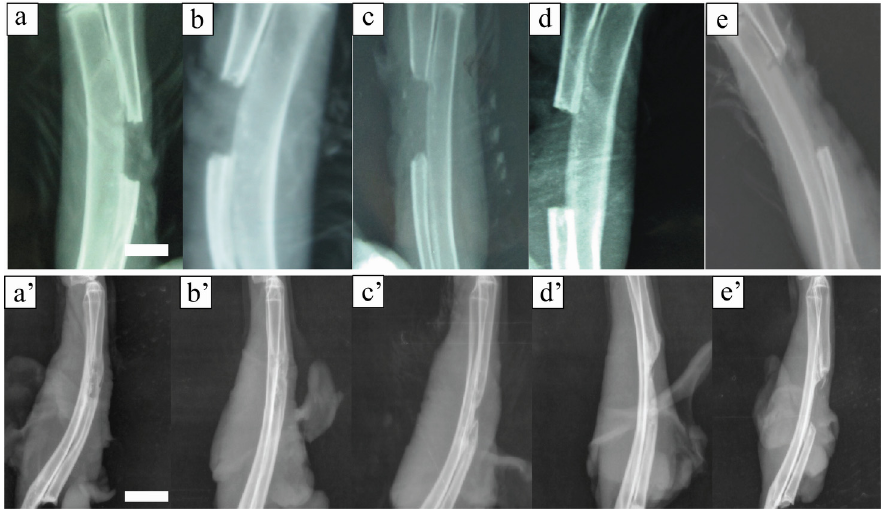
Fig 4. Radiograph of different radius defects just after operation and 12 weeks postoperatively. The size of the central bone defect gradually increased with respect to an increase in created defect size (a,a ’ : 1.0cm, b,b ’ : 1.2cm, c,c ’ : 1.4cm, d,d ’ : 1.7cm, e,e ’ : 2.0 cm, a-e: just after operation, a ’ -e ’ : 12 weeks postoperative, scale bar: